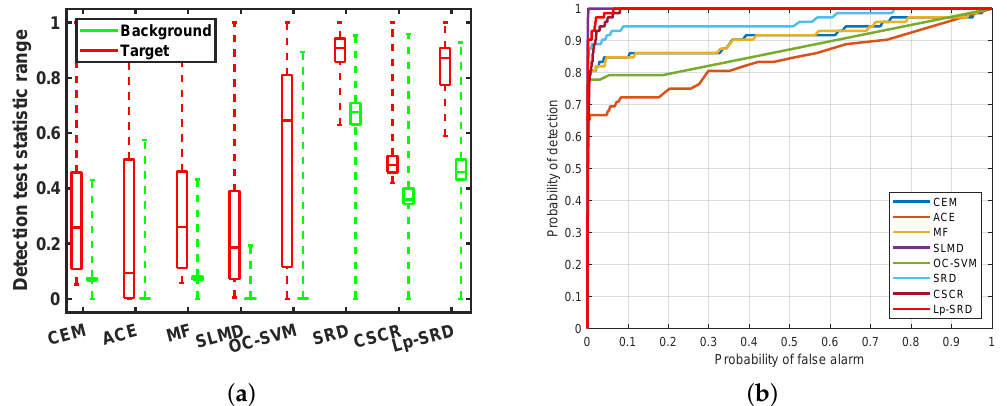
Figure 18. Detection performance using the SpecTIR dataset: ( a ) Statistical separability analysis. ( b ) ROC